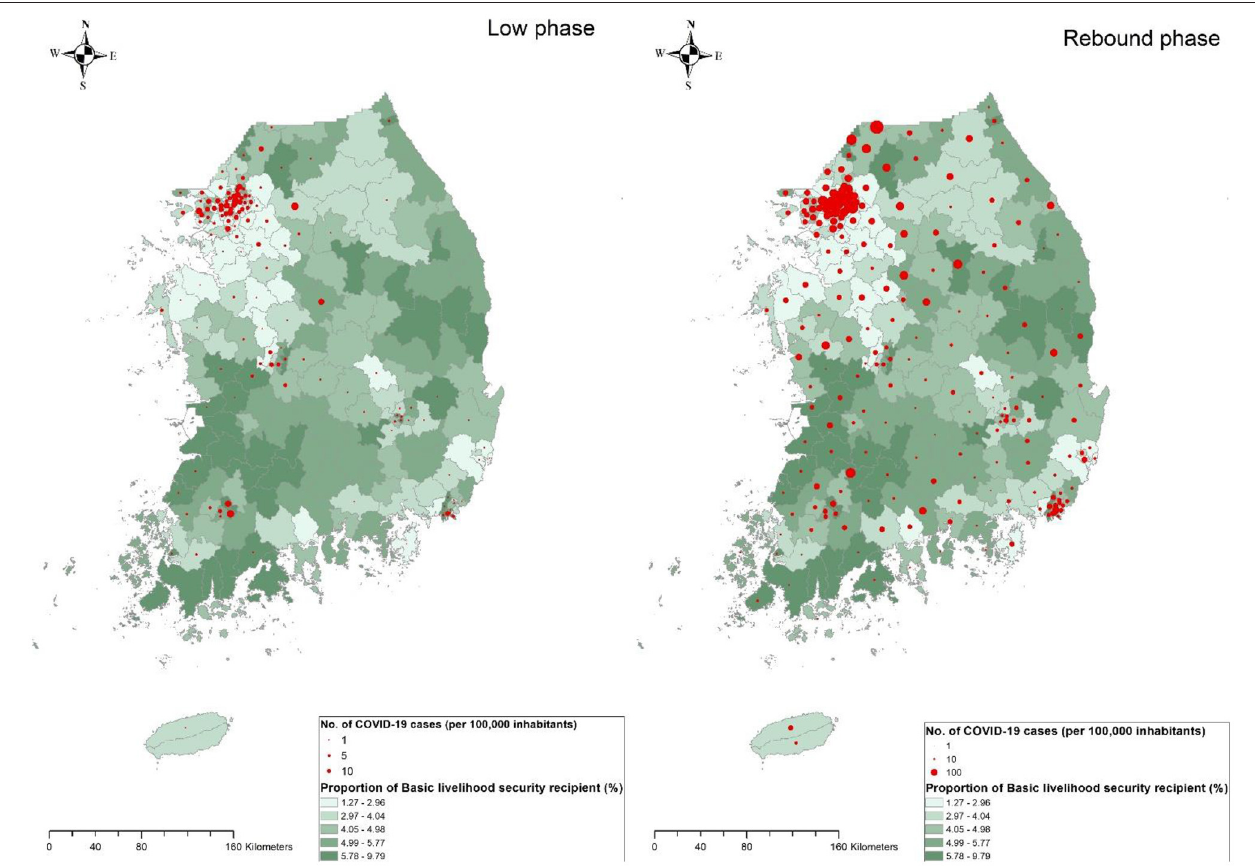
FIGURE 5 | Geographical distribution of the proportion of basic livelihood security recipients with COVID-19 incidence rate by 229 municipalities during the low phase of the epidemic ( left ) or the rebound phase ( right ) The size of the circle is proportional to the cumulative number of reported COVID-19 cases per 100,000 inhabitants during the corresponding period. Green gradient represents the magnitude of the nonemployment